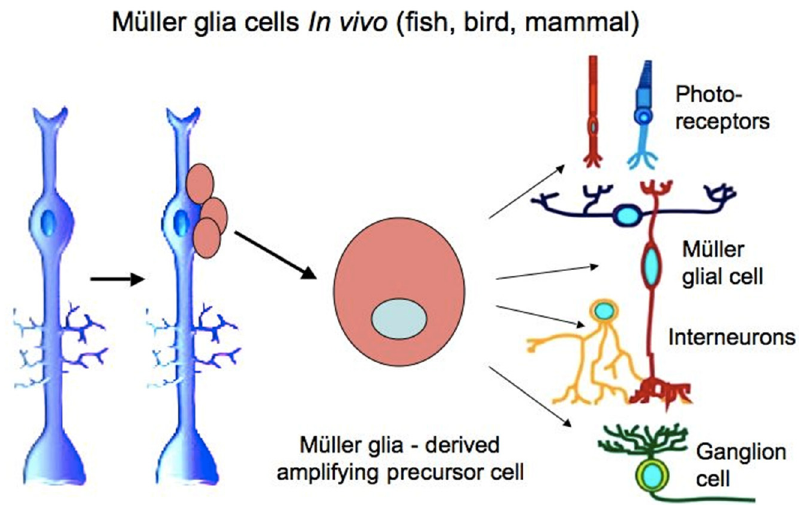
Figure 8. Schematic diagram showing the main steps towards the production of retinal neurons by Müller glial cells in vivo. Data obtained on various animal models are summarized.